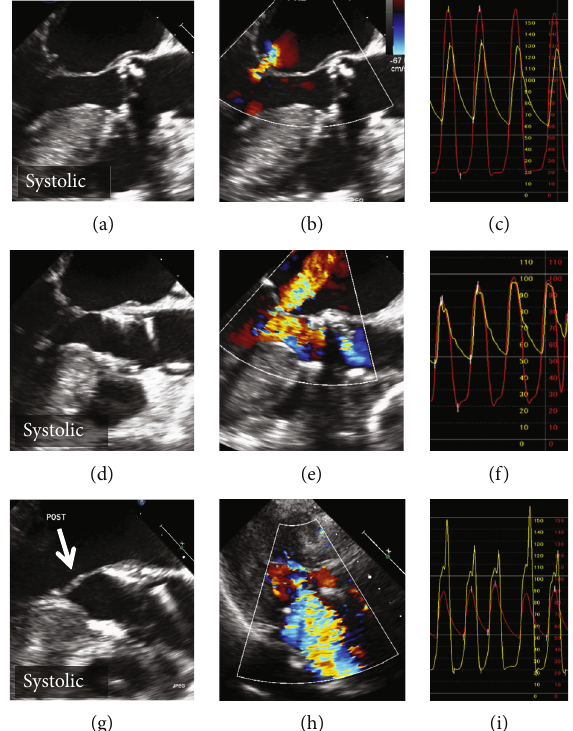
Figure 2: (a – c) No systolic anterior motion (SAM) was observed before transcatheter aortic valve implantation (TAVI). (d – f) Five minutes after TAVI, there was no SAM or pressure gradient. (g) Fifteen minutes later, SAM clearly emerged. (h) Transthoracic echocardiography showed severe mitral regurgitation. (i) Pressure gradient was > 50mmHg at the left ventricular out fl ow